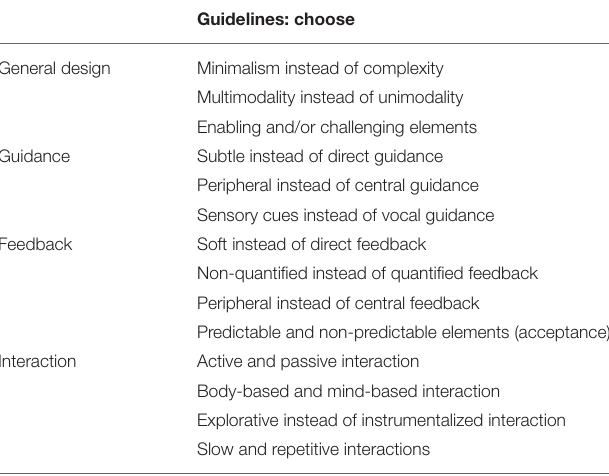
TABLE 3 | Guidelines for mindfulness task design (derived from: (Zhu et al., 2017; Salehzadeh Niksirat et al., 2017; Roo et al., 2017; Niksirat et al., 2019). Guidelines: